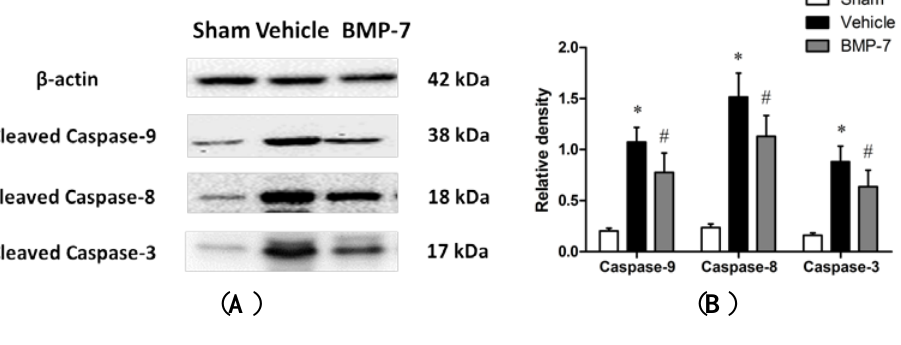
mean ± SD ( n = 10). * p < 0.05 versus sham group; # p < 0.05 versus vehicle